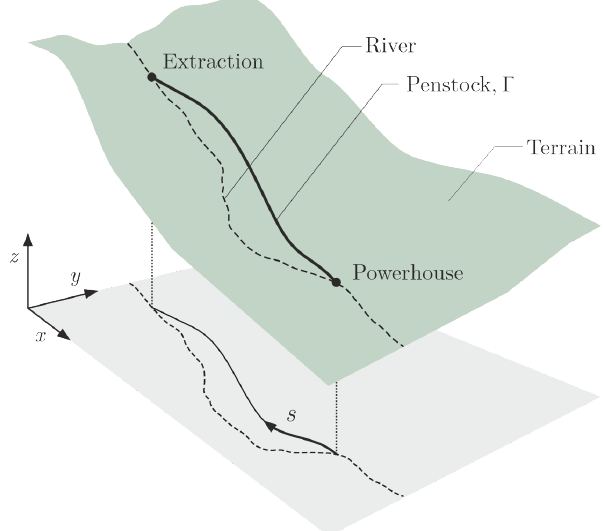
Figure 3. MHPP simplified model through 3D spatial curves.